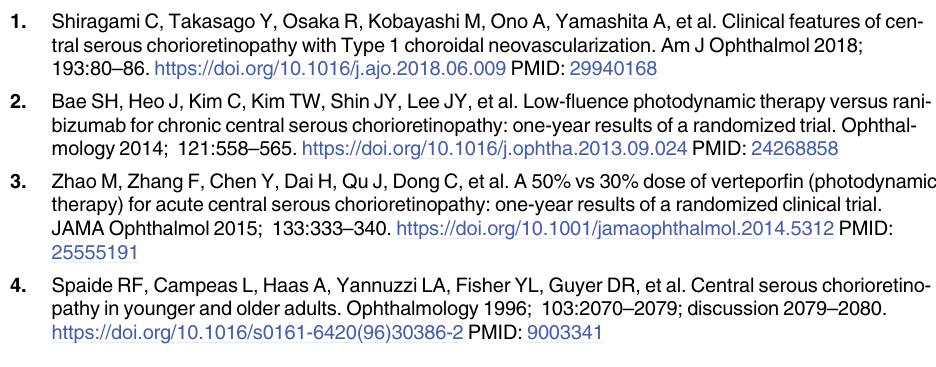
S1 Table. Pretreatment choroidal thickness of patients with central serous chorioretinopa- thy by treatment outcome. The data are shown as means with standard deviations. P-values were calculated using the Mann–Whitney U